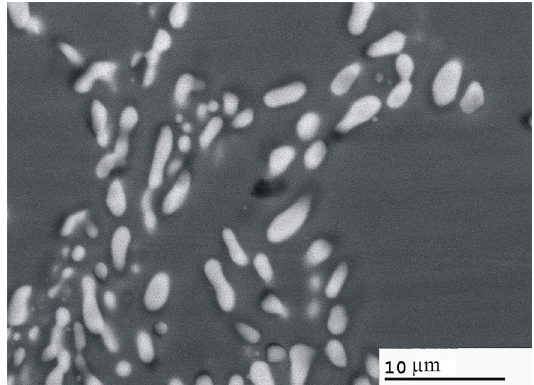
Figure 4. Microstructure of the alloy Al-11%Zn-3%Ca-3.5%Mg in as‑quenched state (500 °С),